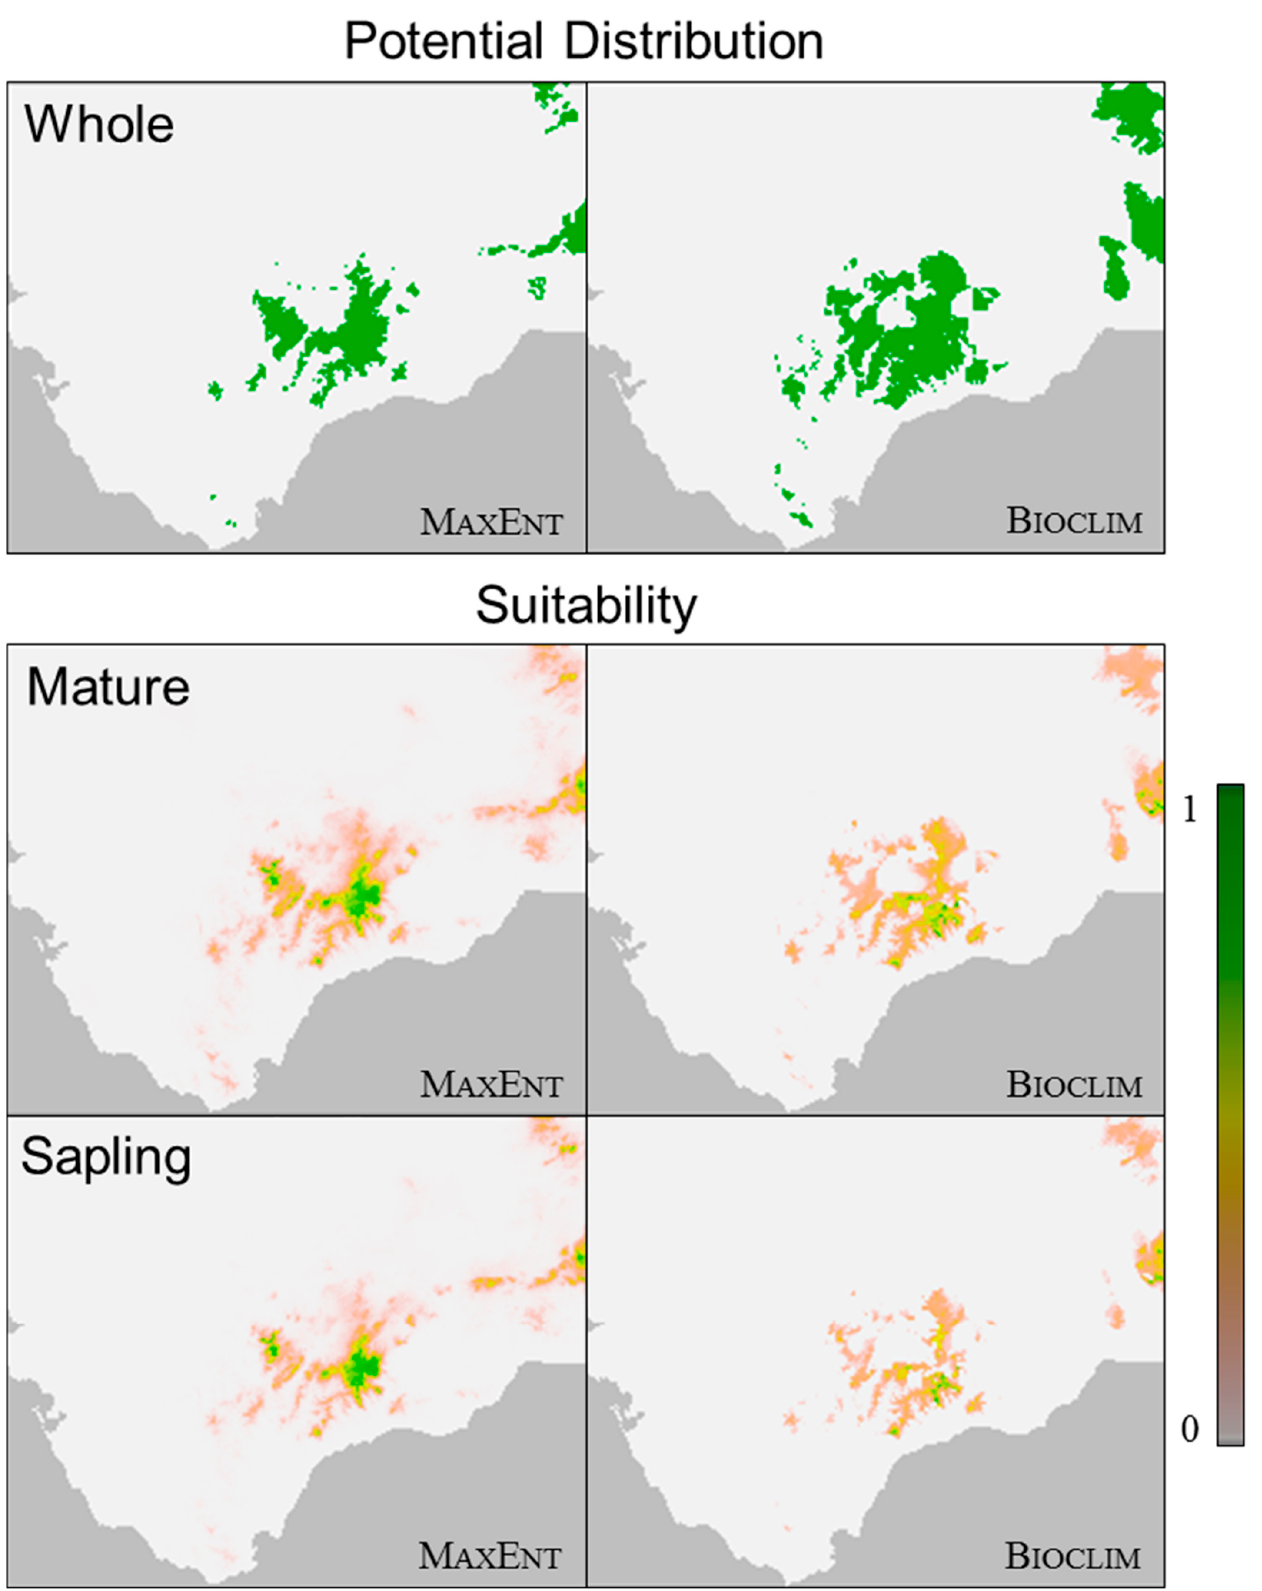
Figure 3. Models in M AX E NT ( left ) and B IOCLIM ( right ) for Abies pinsapo Boiss. in the Baetic System. The figures show the potential habitat (in binary terms) for the species (“whole”, i.e., all ages, on the top ) and suitability (0 to 1) for the “mature” group (centre) and “sapling” group ( bottom ).